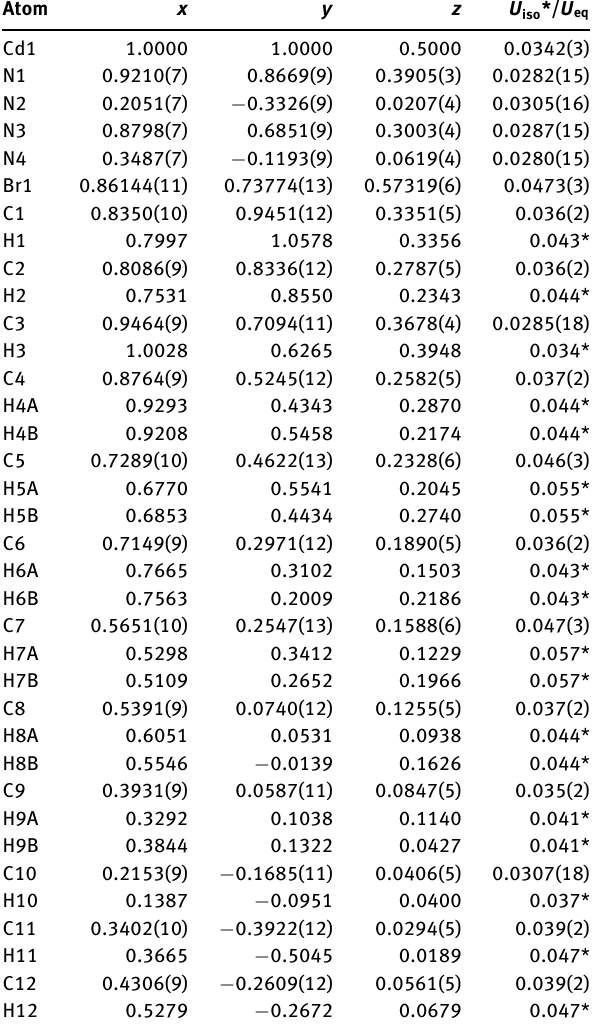
Table 2: Fractional atomic coordinates and isotropic or equivalent isotropic displacement parameters (Å 2